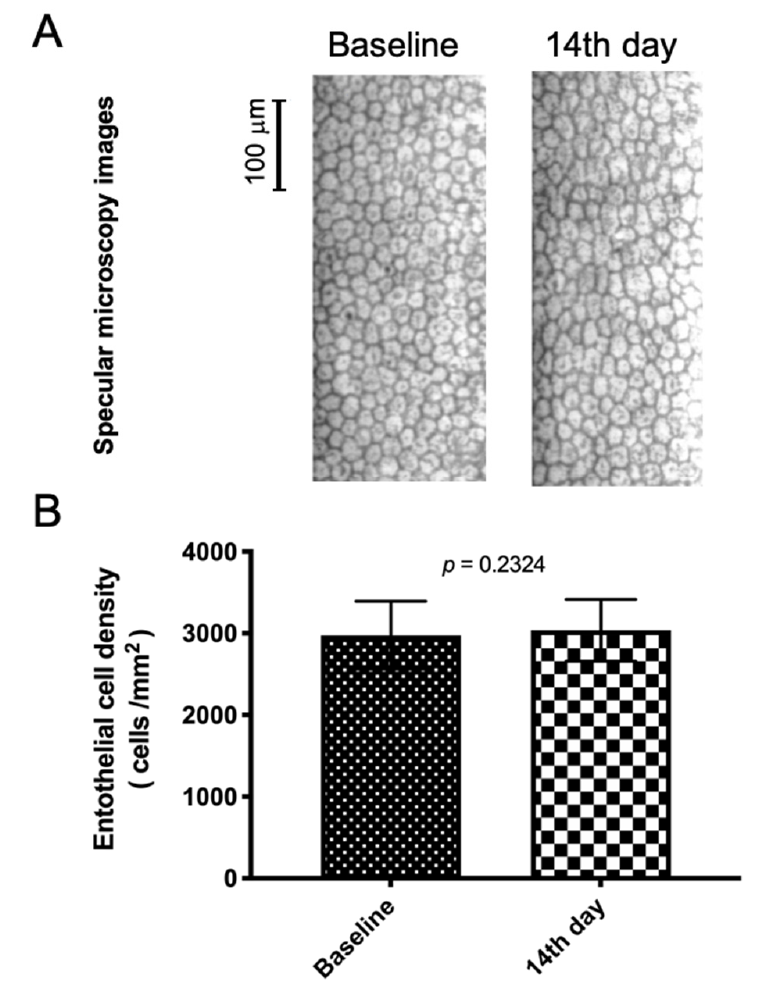
Figure 3. Corneal endothelial cell density analysis in healthy subjects treated with triamcinolone acetonide-loaded liposomes formulation. ( A ) Images of specular microscopy of a representative case at baseline and after 14 days of TALF instillation. ( B ) Column bar graph from corneal endothelial cell density (cECD) analysis. Non-significant differences in cECD values were established between baseline and after 14 days of TALF instillation. TALF; triamcinolone acetonide-loaded liposomes